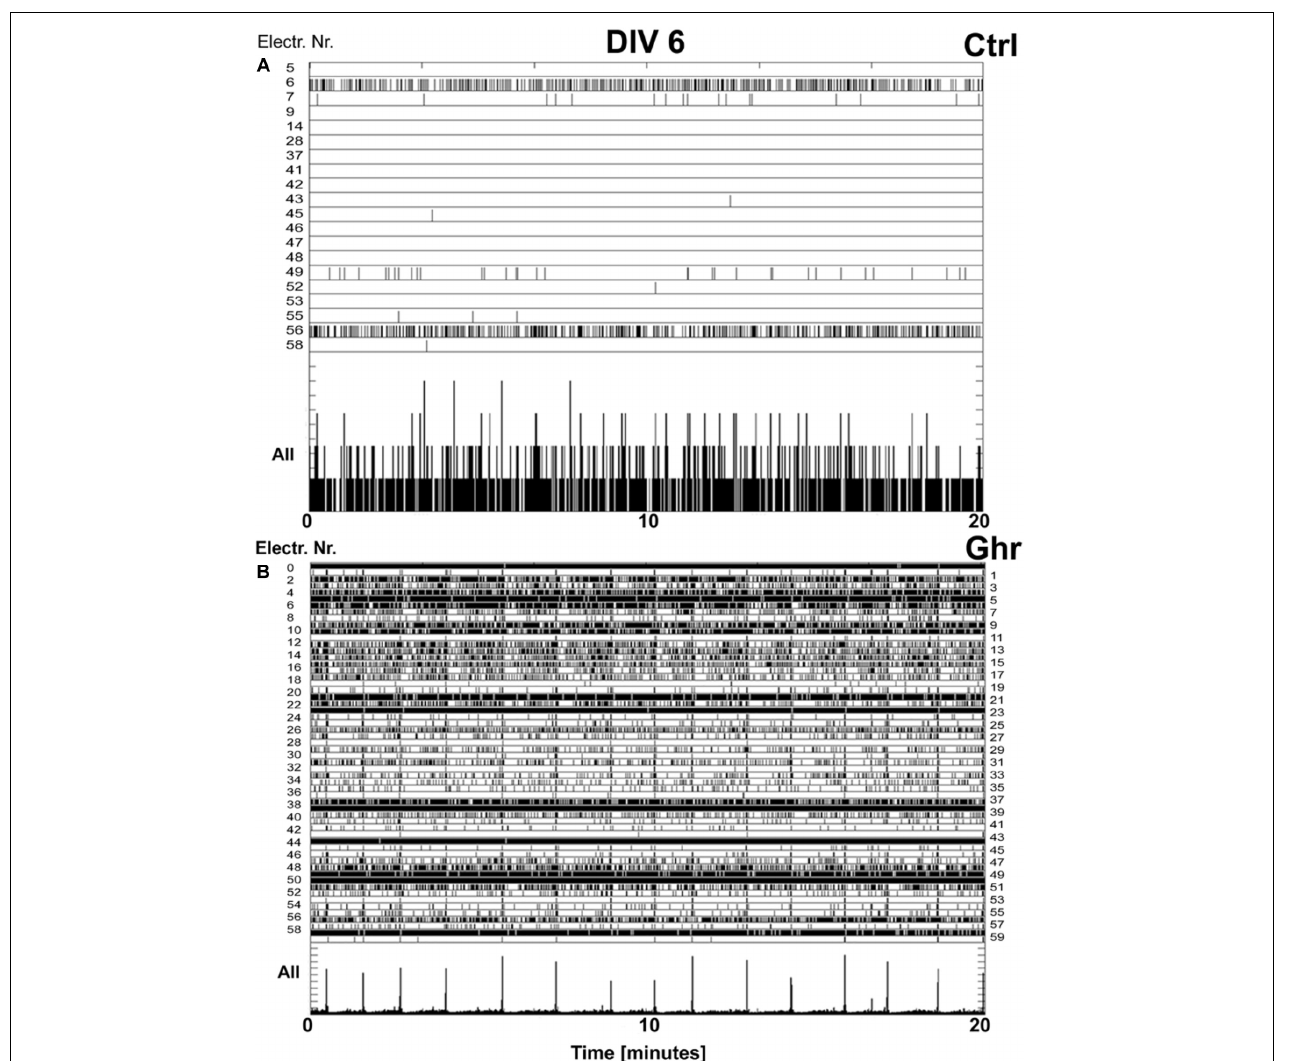
FIGURE 2 | Effect of ghrelin on network activity. Raster plots of the neuronal activity recorded over 20 min ( x -axis) in cultures incubated with ghrelin and controls at age 6 days in vitro (DIV). The top rows of the panels depict only the electrodes in contact with active neurons (electrode numbers are on y -axis). Each tick represents a recorded action potential. The bottom rows of the two panels represent the summed network activity. (A) Network activity in a sister culture under control conditions, 47 spikes recorded in 1 min, immature activity pattern. (B) Network activity in a culture chronically treated with ghrelin, 3,740 spikes recorded in 1 min, showing mature activity pattern. With permission from BMC Neuroscience (Stoyanova and le Feber, 2014).